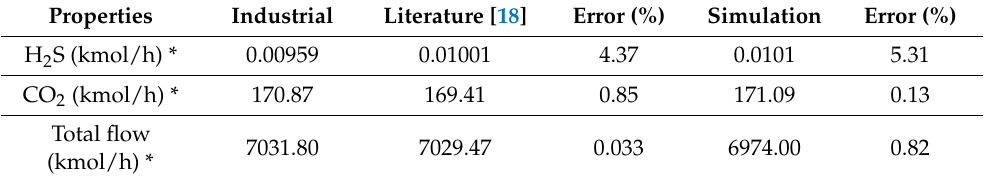
Figure 3. Process flowsheet for acid gas treatment. Table 2. Comparison of H 2 S, CO 2 and total flow of sweet gas between industrial, literature and our simulation data.